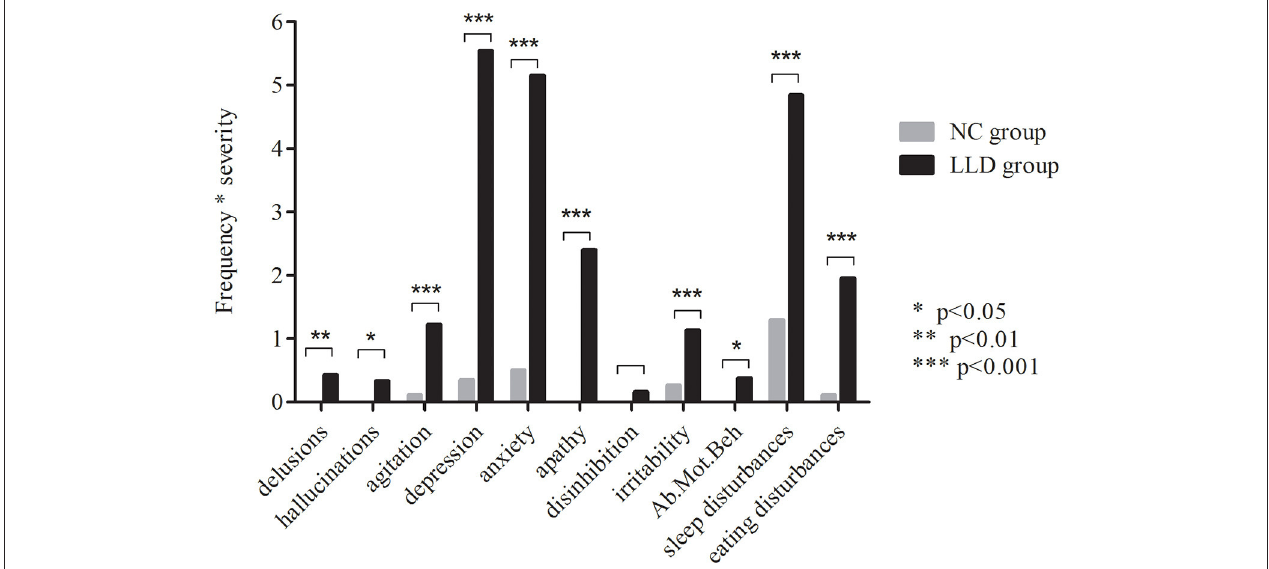
FIGURE 1 | Neuropsychiatric symptoms in NCs and LLD patients. The figure shows the scores of Frequency * Severity in NCs (in gray) and LLD patients (in black), as assessed by NPI; euphoria item has zero variance, thus is not included in the analysis; NC, normal control; LLD, late life depression; Ab. Mot Beh, aberrant motor